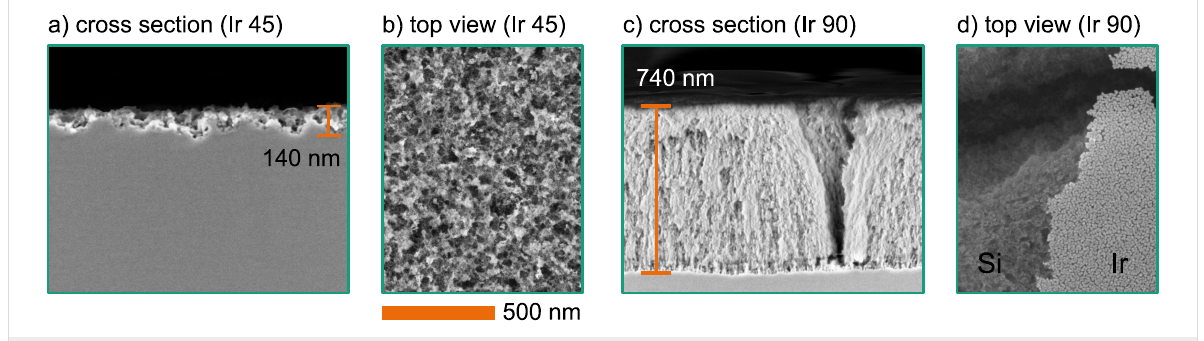
Figure 9: SEM images of etched structures (with 100 mmol/L H 2 O 2 and 1.73 mol/L HF for 10 min) using Ir particles after 45 ALD cyles ((a): cross section; (b): top view), and after 90 ALD cycles ((c): cross section; (d): top view with partial Ir coverage).